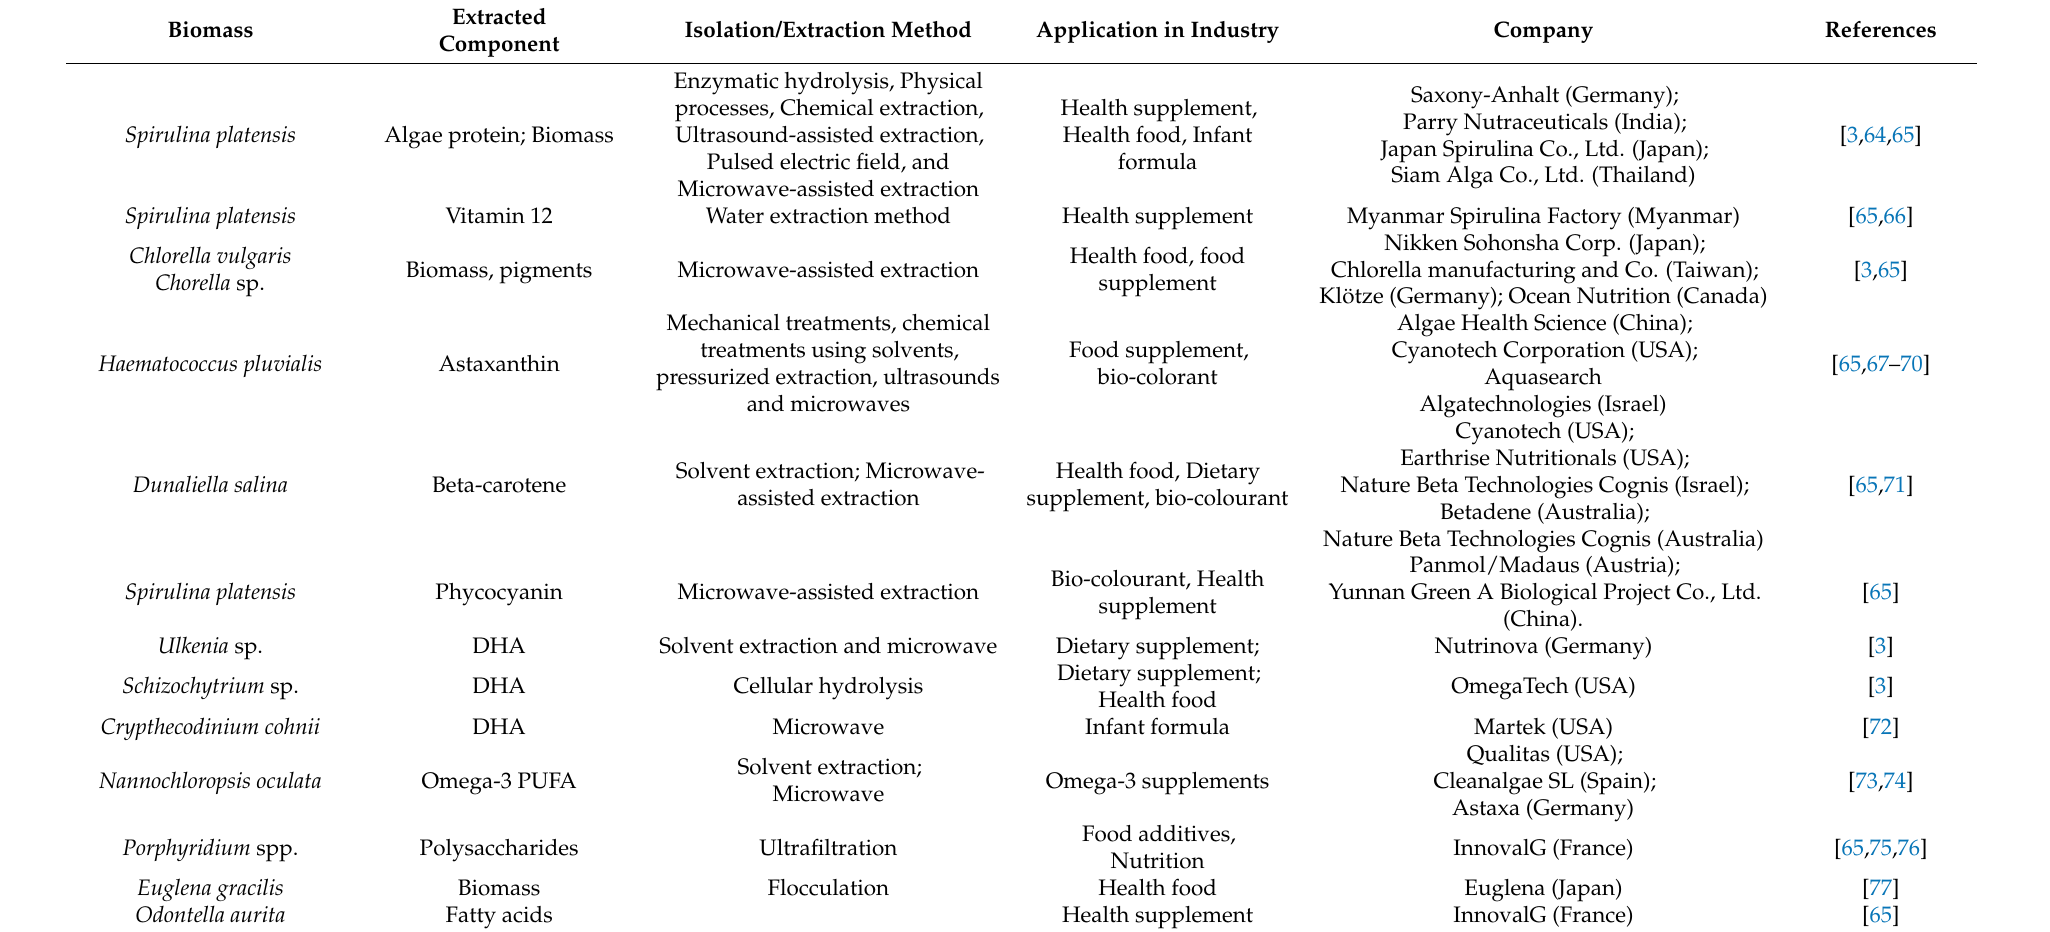
Table 3. List of commercialized strain, industry application, companies, and the countries